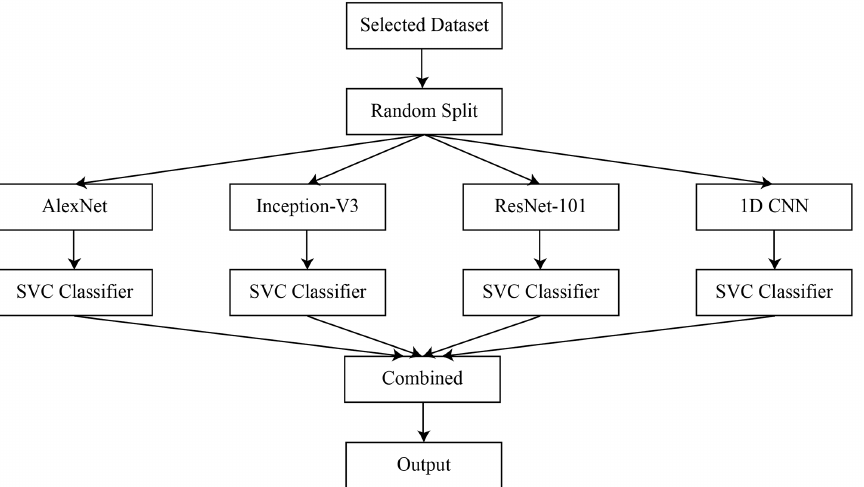
Figure 1. Architecture of the proposed Bagged Ensemble Learning